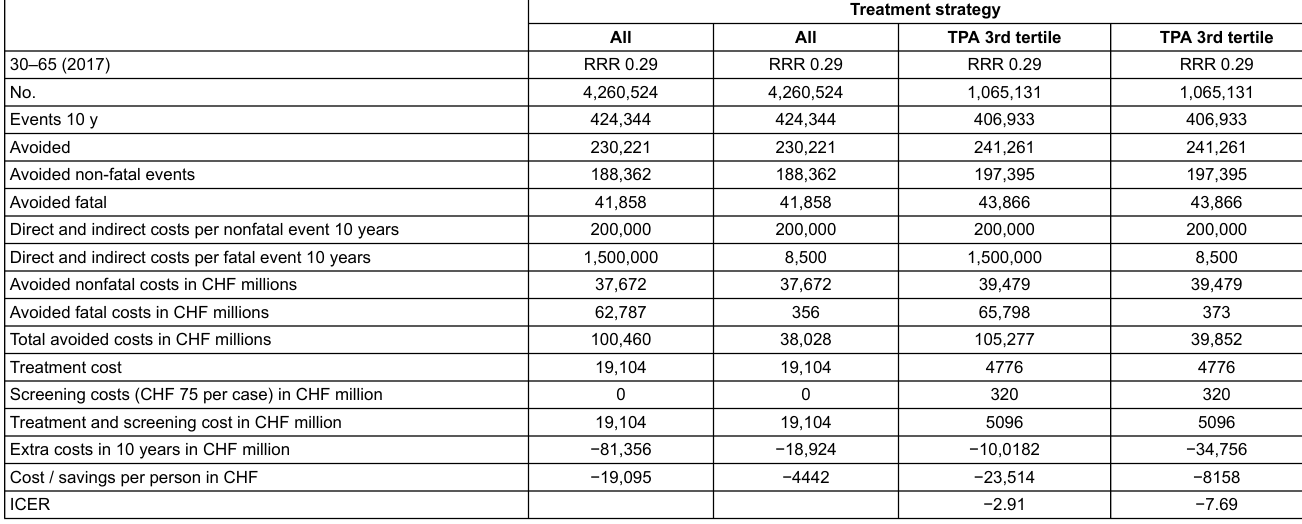
Table S2: Sensitivity analysis using Arteris ratio of fatal to nonfatal cases (1:6.3). The analysis using the Swiss Medical Board ratio is presented in table